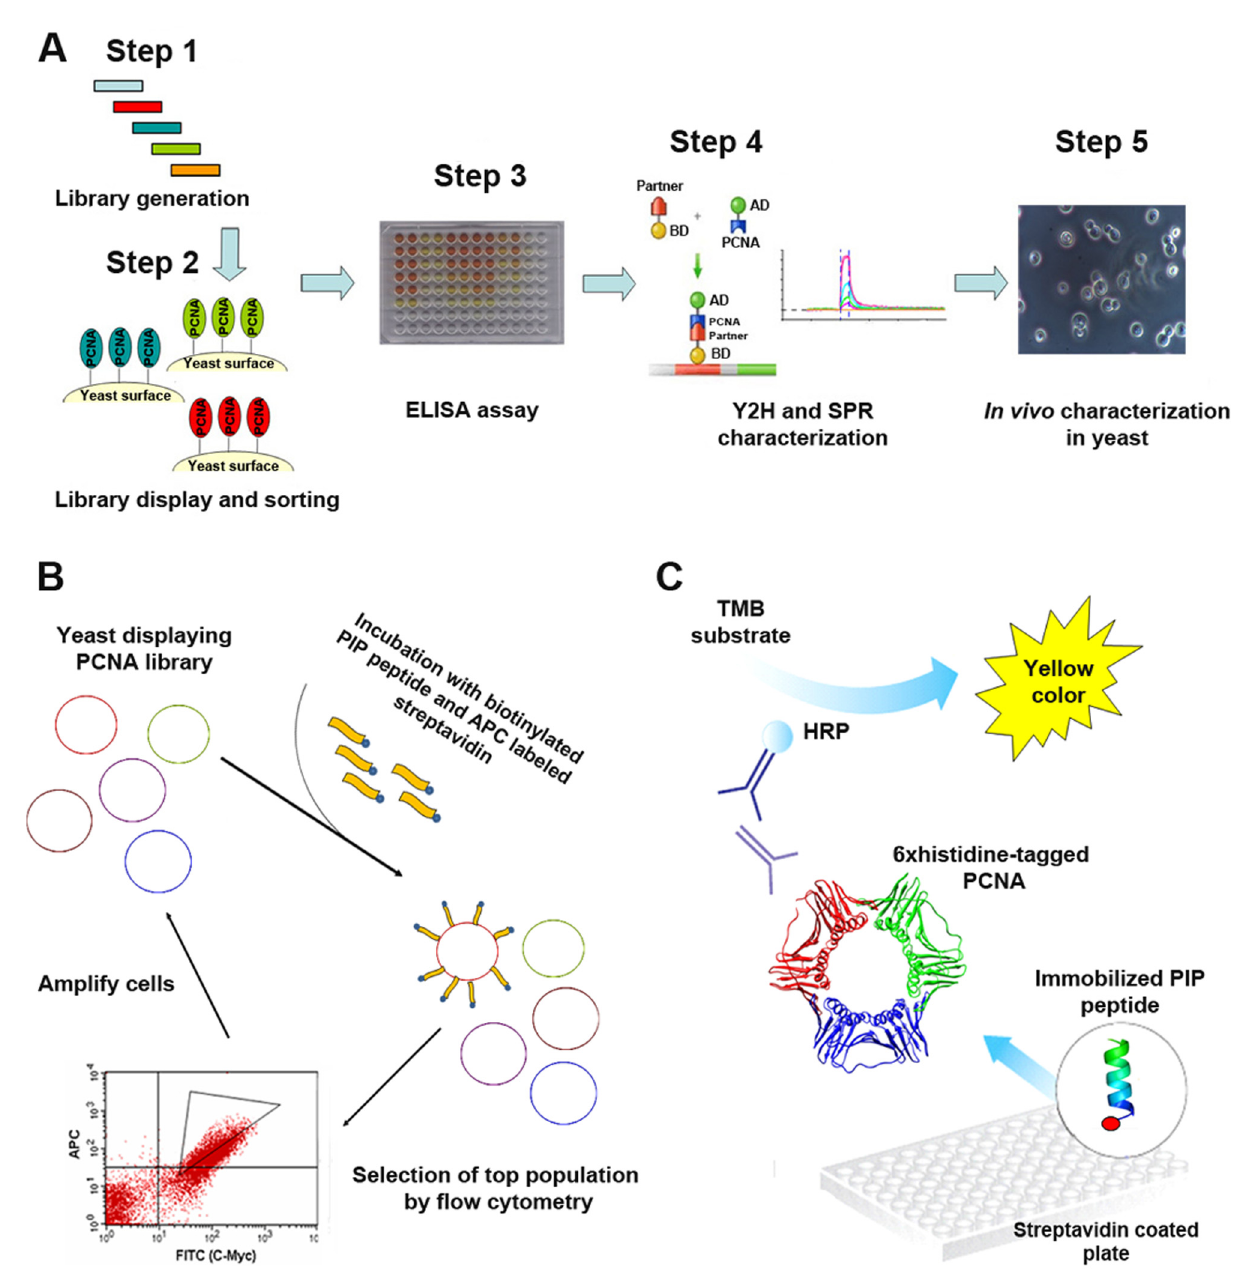
Figure 2. Work-flow for the generation and characterization of PCNA mutants with enhanced affinity for different partners. (A) Overview of the workflow, including generation and sorting of PCNA libraries displayed on the yeast cell surface (Step 1 and 2) and subsequently subjecting the enriched libraries to ELISA to identify improved mutants (Step 3). Binding characterization of the selected PCNA mutants by the yeast two hybrid system (Y2H) and surface plasmon resonance (SPR) is next performed (Step 4). Finally, in vivo characterization of the PCNA mutants in yeast cells is conducted (Step 5). (B) Detailed description of the selection process of the PCNA library displayed on the yeast cell surface for PCNA mutants with improved affinity for PIP peptides derived from the different partners, relying on yeast surface display (YSD) and flow cytometry (Step 2). (C) Detailed description of the ELISA assay used for the detection of PCNA-PIP peptide interactions (Step 3). Target biotinylated PIP peptides derived from the different partners (see Figure S1 for sequences) are immobilized on streptavidin-coated plates. E. coli cell lysates containing 6 6 histidine-tagged mutant PCNA are applied to the plates. Following washing, primary and secondary antibodies are added to facilitate the detection of PCNA binding to the PIP peptides. doi:10.1371/journal.pbio.1000507.g002 cyanin (APC), in addition to a fluorescent antibody against the (Figure 2A, Step 1) [22]. To enrich the PCNA library for mutants myc-tagged PCNA. The top fluorescent cell population was with enhanced affinity for the target partner, the displayed PCNA selected by fluorescence-activated cell sorting (FACS; Figure 2A, library was incubated with biotinylated peptide derived from the Step 2 and Figure 2B). Next, the enriched libraries were sub- target partner (see below) and streptavidin-conjugated allophyco-